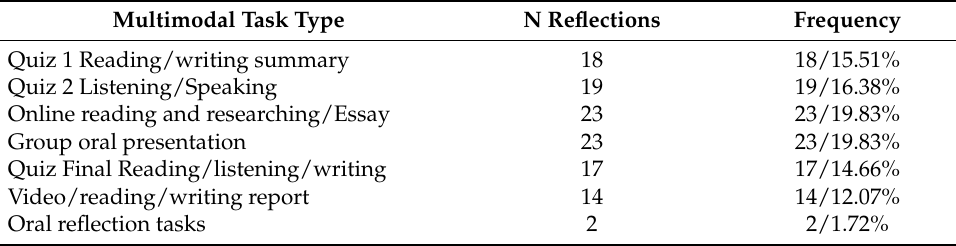
Table 2. Transcribed number of student oral reflections and frequency in